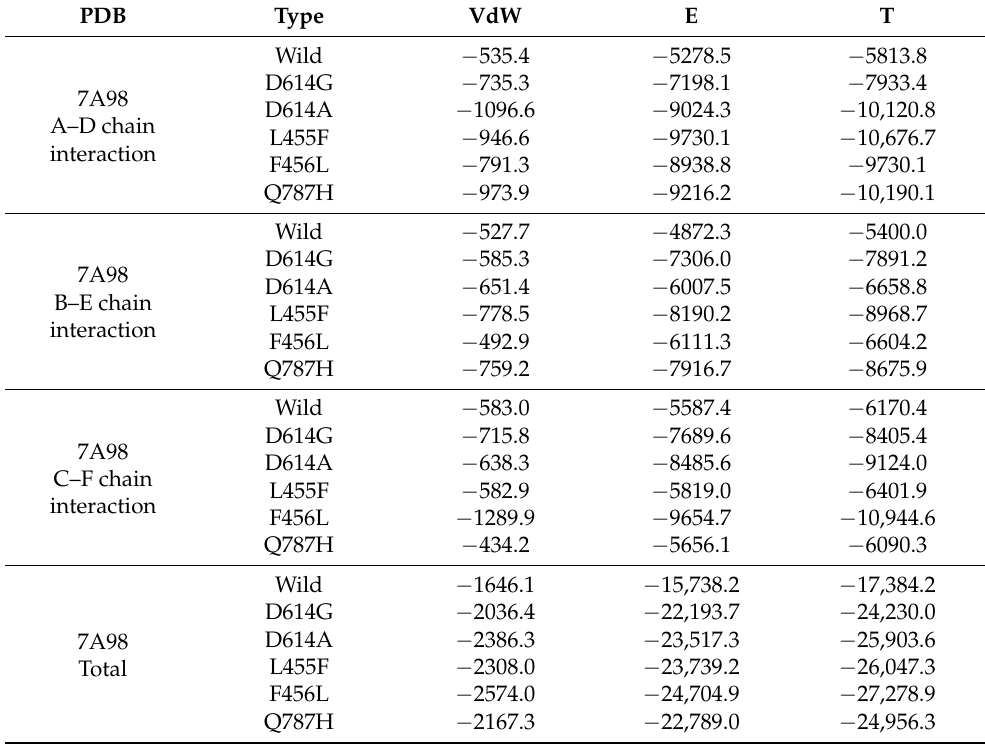
Table 4. Summary of MM/PBSA between the S protein and ACE2 in the 3-open-complex form. VdW indicates van der Waals energy, E denotes electrostatic energy, and T is total energy (kJ/mol). The values were measured in the final trajectory (10